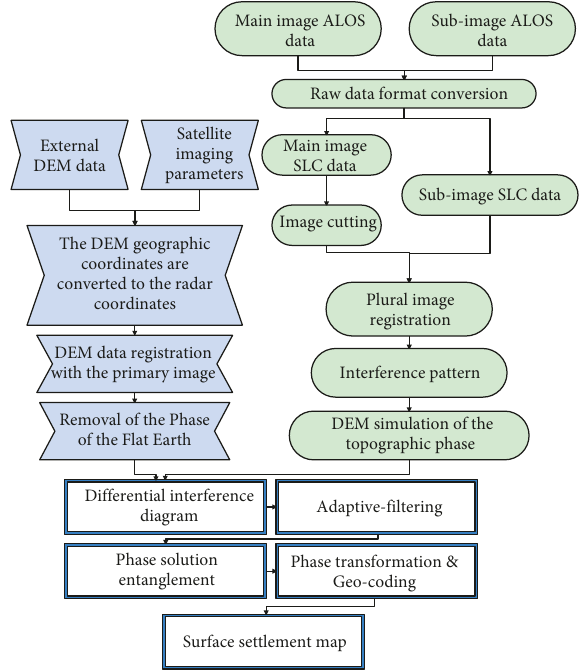
Figure 2: Land remote sensing image recognition